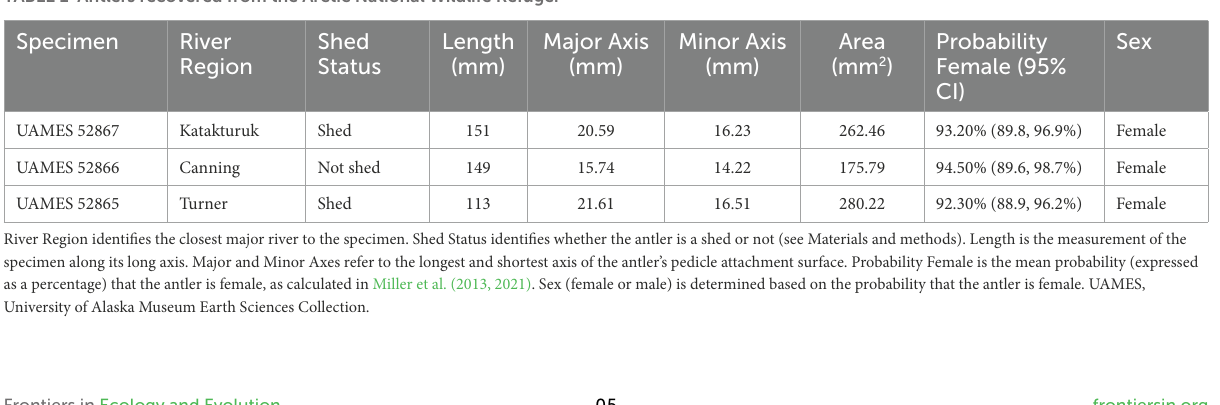
TABLE 1 Antlers recovered from the Arctic National Wildlife